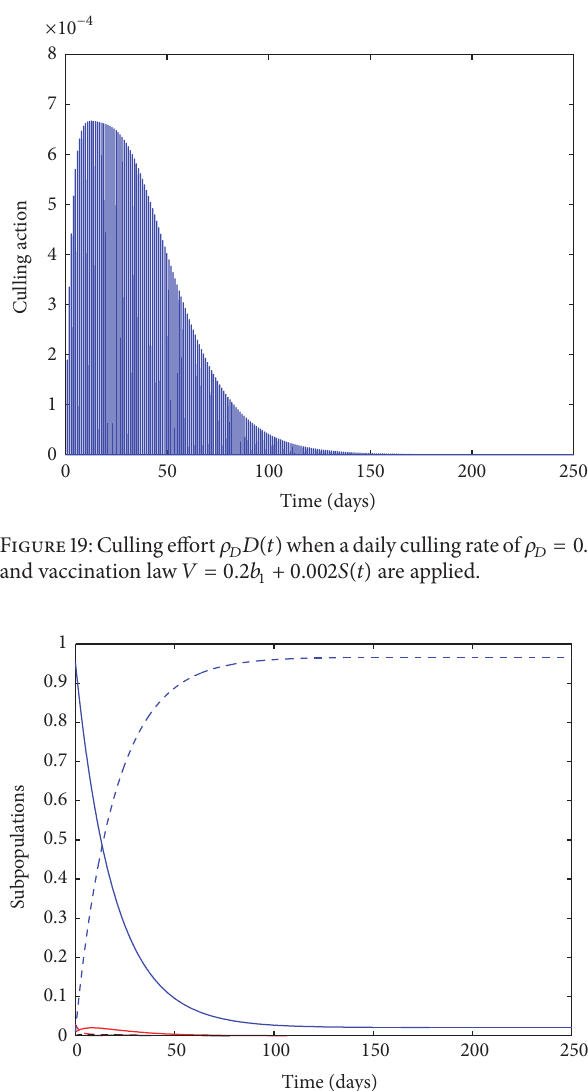
Figure 18: Vaccination function 𝑉 = 0.2𝑏 1 + 0.002𝑆(𝑡) when a daily culling rate of 𝜌 𝐷 = 0.1 is also applied.